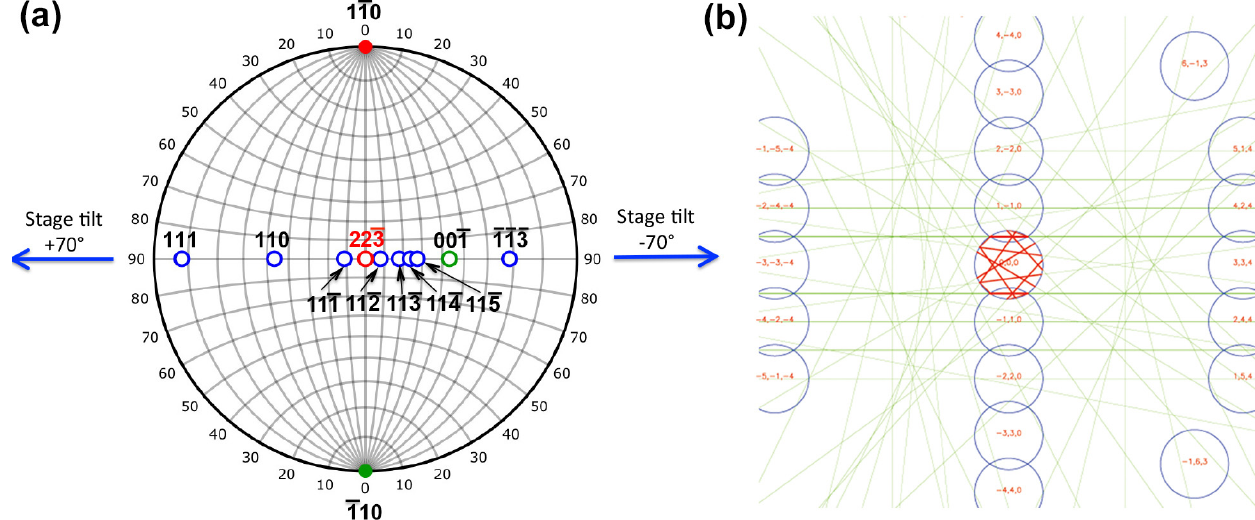
Figure 2. ( a ) Stereographic projection indicating changes of zone axes as a function of stage tilt angle. The initial beam incidence is close to [223 reflections are always excited during the tilt series acquisition; ( b ) A simulated convergent-beam electron diffraction (CBED) pattern with the [223